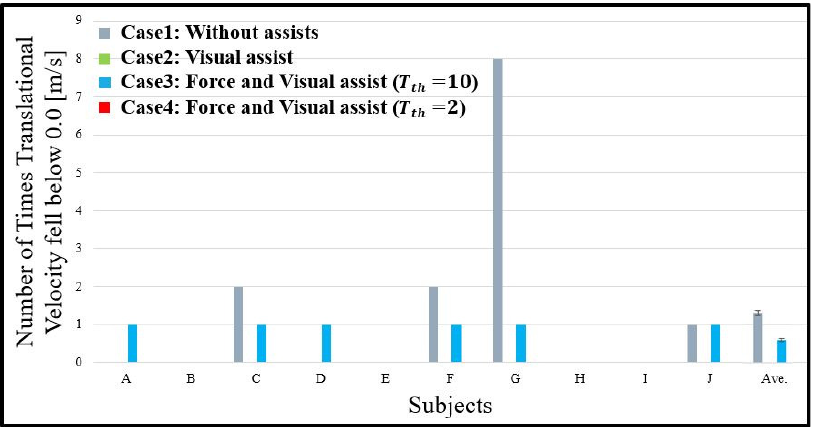
Figure 13. Experimental results of number of times translational velocity fell below 0.0 m/s.